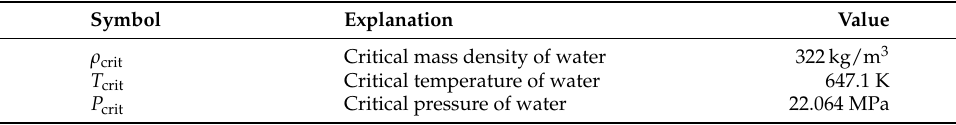
Table A2. Liquid water